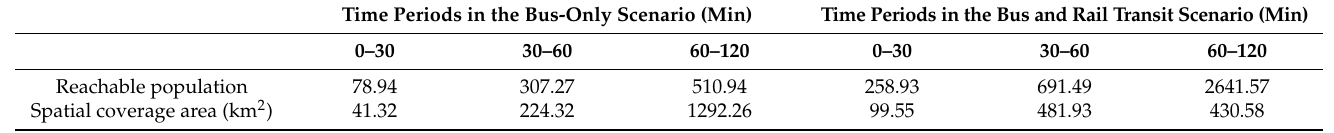
Table 2. The difference in the isochronous areal analysis of the CBD between the bus-only and bus and rail transit